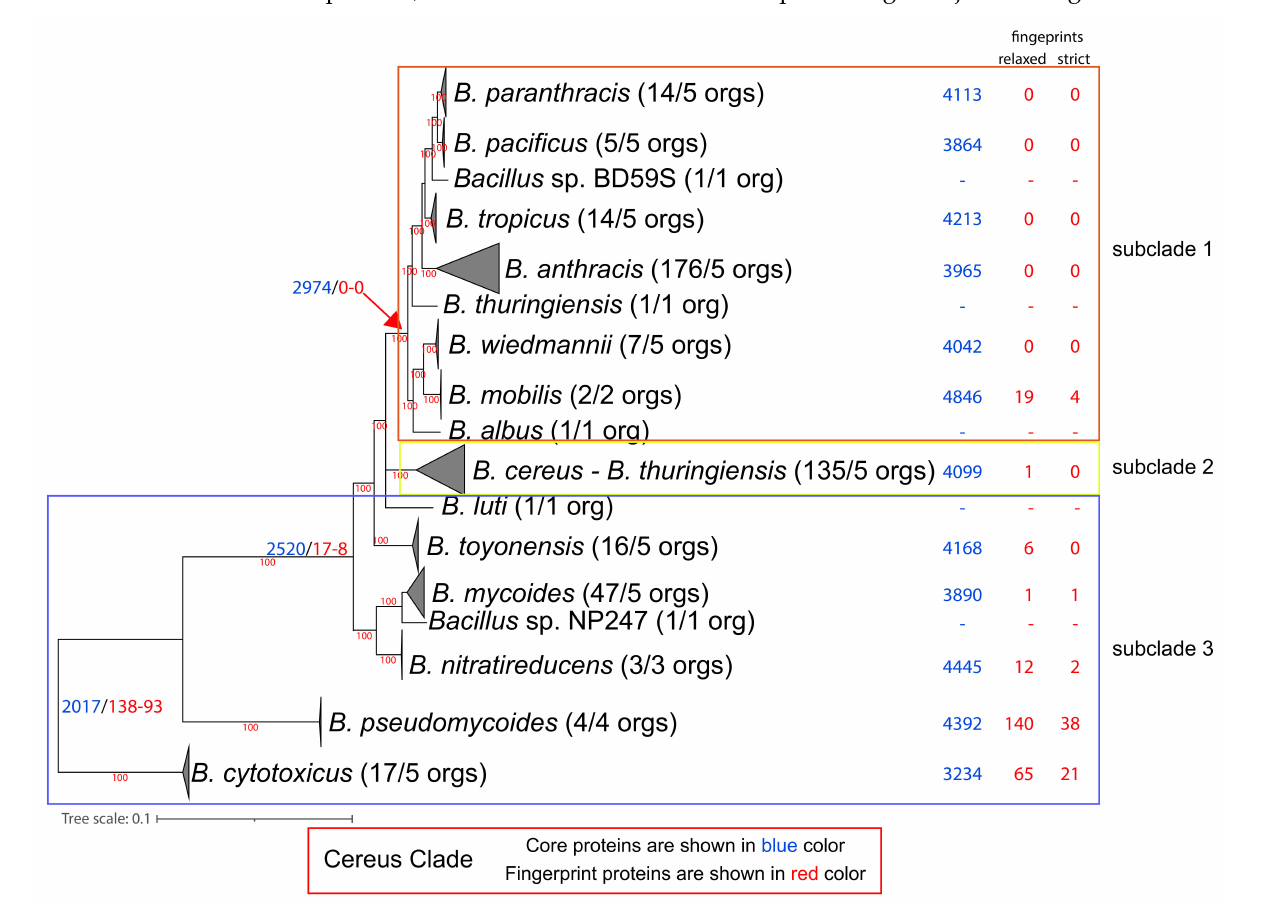
Figure 3. Phylogenomic ML tree (QTree2-Q.Plant + I + F + G4-aLRT) of the Cereus Clade, based on 812 core protein-orthologous groups from 445 proteomes. For ease of visualization, certain evolutionary clusters have been collapsed. The full tree is available as Supplementary Figure S3. Next to the species name, in parentheses, is the number of complete genomes that are available and, on their right, is the number of genomes used in the normalized dataset. Further to the right of the species names and at the common ancestor of a lineage, we denote with blue and red colors the number of core and (relaxed/strict) fingerprint proteins for each lineage (based on the normalized